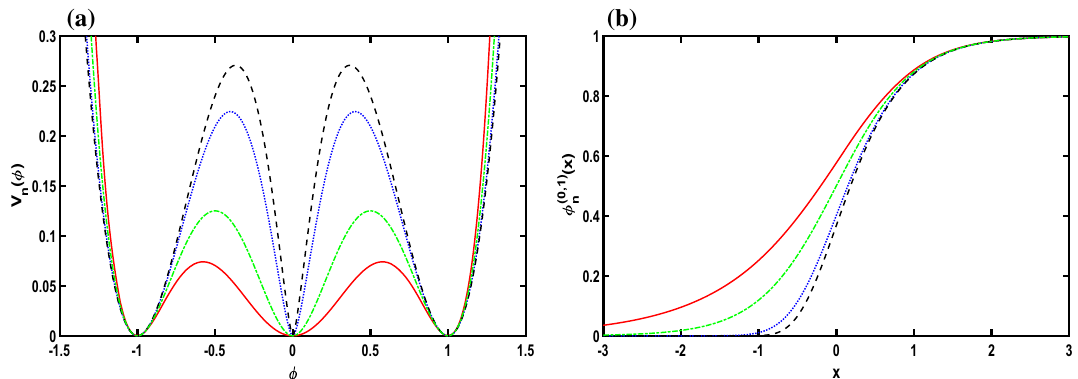
Fig. 1 a Potential V (φ) and b field configurations φ ( 0 , 1 ) n ( x ) for n = 1 (red solid), n = 2 (green dash-dotted) n = 10 (blue dotted) and n →